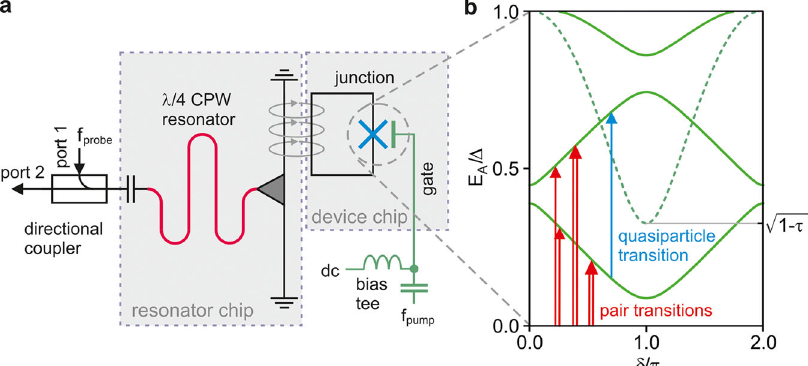
Fig. 1 Schematic sketch of the measurement setup and overview of the different excitations and transitions. a The nanowire Josephson junction on the device chip is inductively coupled to the λ /4 coplanar waveguide (CPW) resonator on the sapphire-based superconducting microwave circuit. The gate is connected to an external bias tee which supplies the dc-bias and the rf signal of the second tone. b Excitation representation of Andreev levels for a short junction with L / ξ < 1 (dashed line) and a long junction with L / ξ = 2.74 (solid lines). The transparency was set to typical state-of-the-art values for epitaxial nanowire Josephson junctions ( τ = 0.895). Here, L corresponds to the effective junction length, ξ = ℏ v F / Δ is the superconducting coherence length, v F the Fermi velocity, and Δ the superconducting gap. The blue and red arrows indicate possible single quasiparticle (odd) and quasiparticle pair (even) transitions,